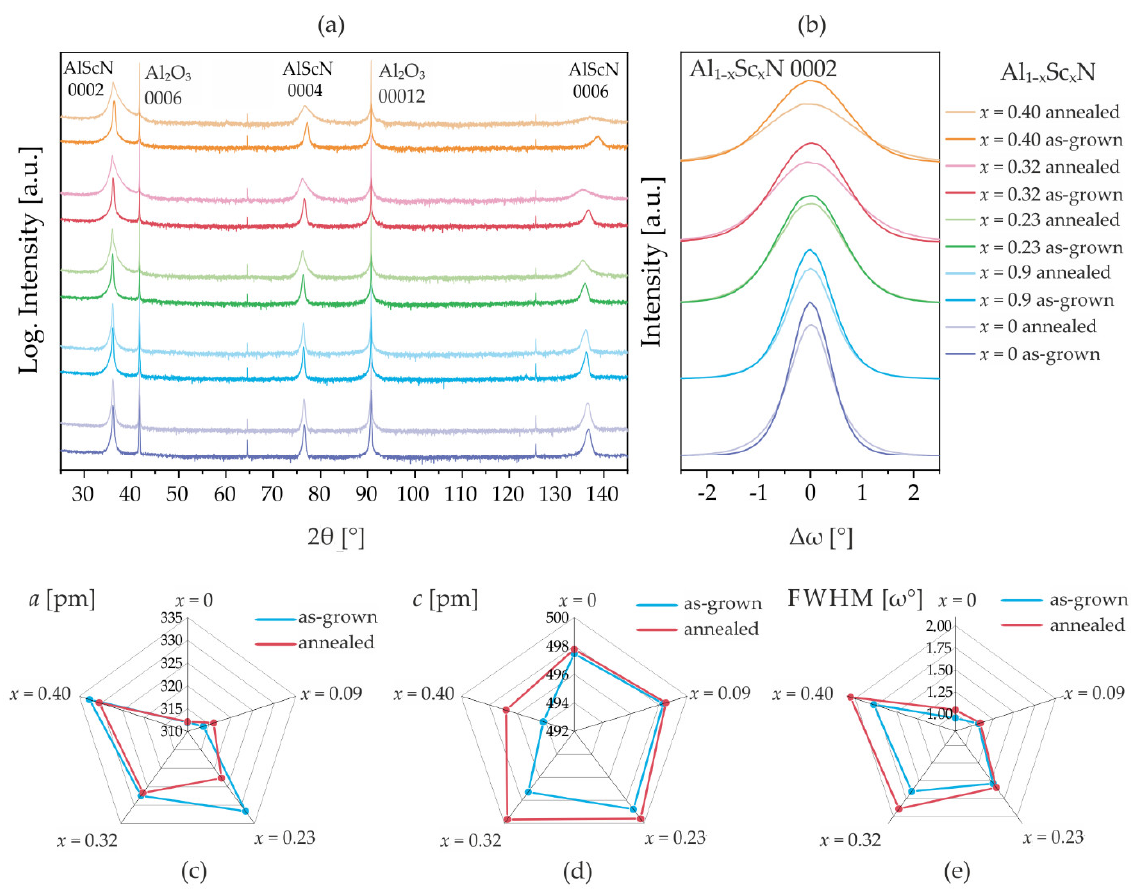
Figure 4. Analysis of Al 1 − x Sc x N/Al 2 O 3 (0 ≤ x ≤ 40.0) before and after in situ thermal annealing (sample set #2). ( a ) XRD 2θ/θ diffractograms. ( b ) XRD rocking curve measurements of the 0002-reflections. Summary of changes in lattice parameters a ( c ) and c ( d ) calculated from symmetric and asymmetric measurements, ω-FWHM ( e ) calculated from the XRD rocking curves. Table 2. Lattice parameters and mosaicity analyses of Al 1−x Sc x N (0 ≤ x ≤ 0.4) thin films by XRD before and after thermal annealing (sample set #2).